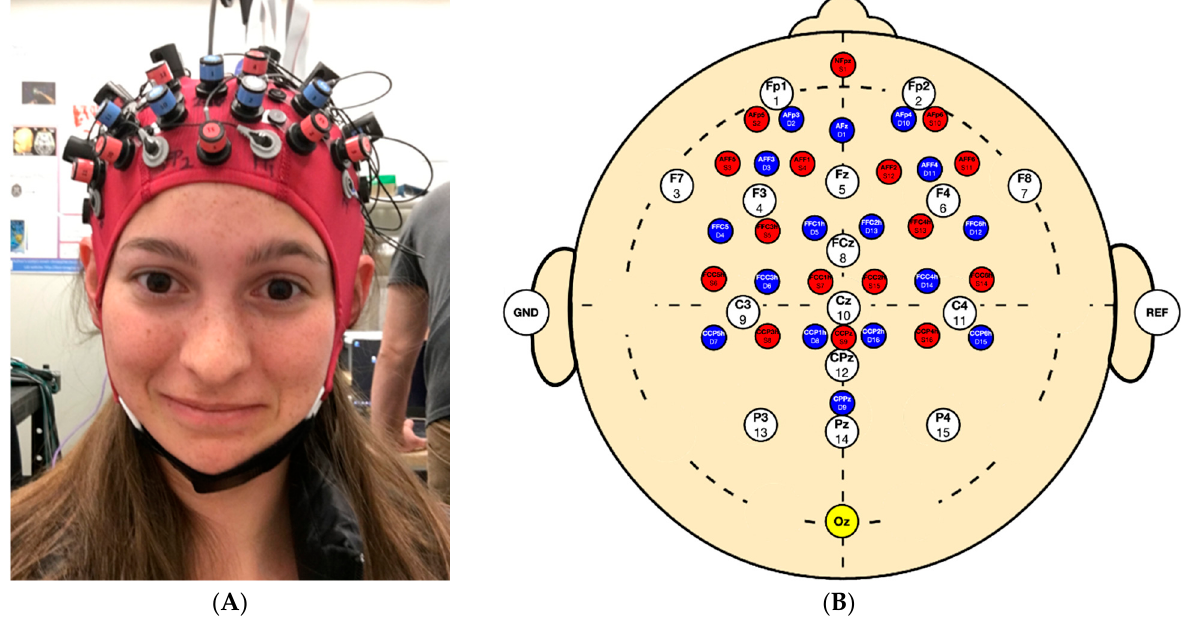
Figure 1. ( A ) Cap setup showing experiment setup and ( B ) montage demonstrating the position of the accelerometer in yellow at Oz.